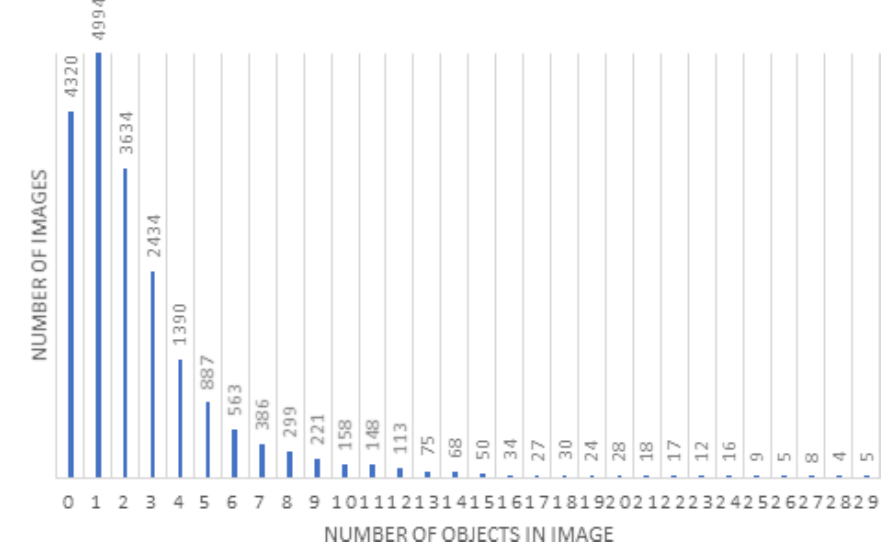
Figure 5. Average distribution of objects in images – data set with 20000 images.